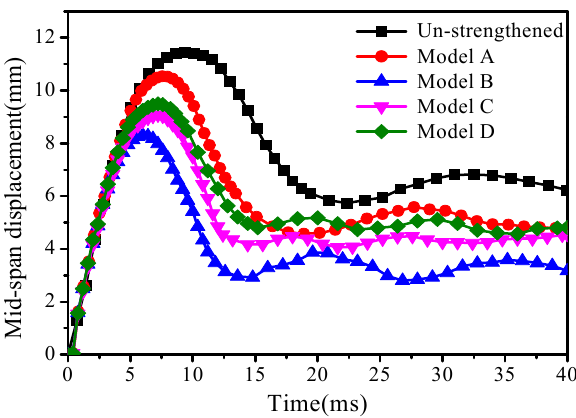
Figure 13. Mid-span displacement-time histories of T-beams strengthened with different CFRP strengthening modes.